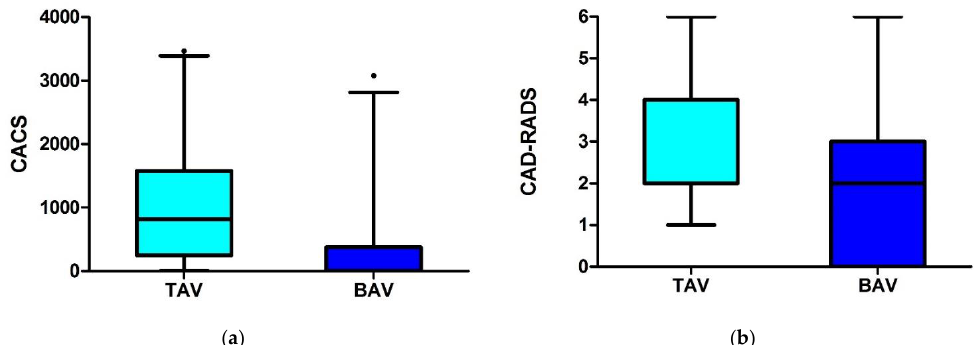
Figure 1. ( a ) Computed tomography (CT) findings ( a ) Coronary artery calcium score (CACS) in patients with bicuspid aortic valve (BAV) stenosis was significantly lower ( p < 0.001) as compared to tricuspid aortic stenosis (TAV). ( b ). Coronary artery stenosis severity (CADRADS) in patients with bicuspid aortic valve (BAV) stenosis was lower ( p < 0.001) as compared to tricuspid aortic stenosis (TAV). Dot = extreme values.